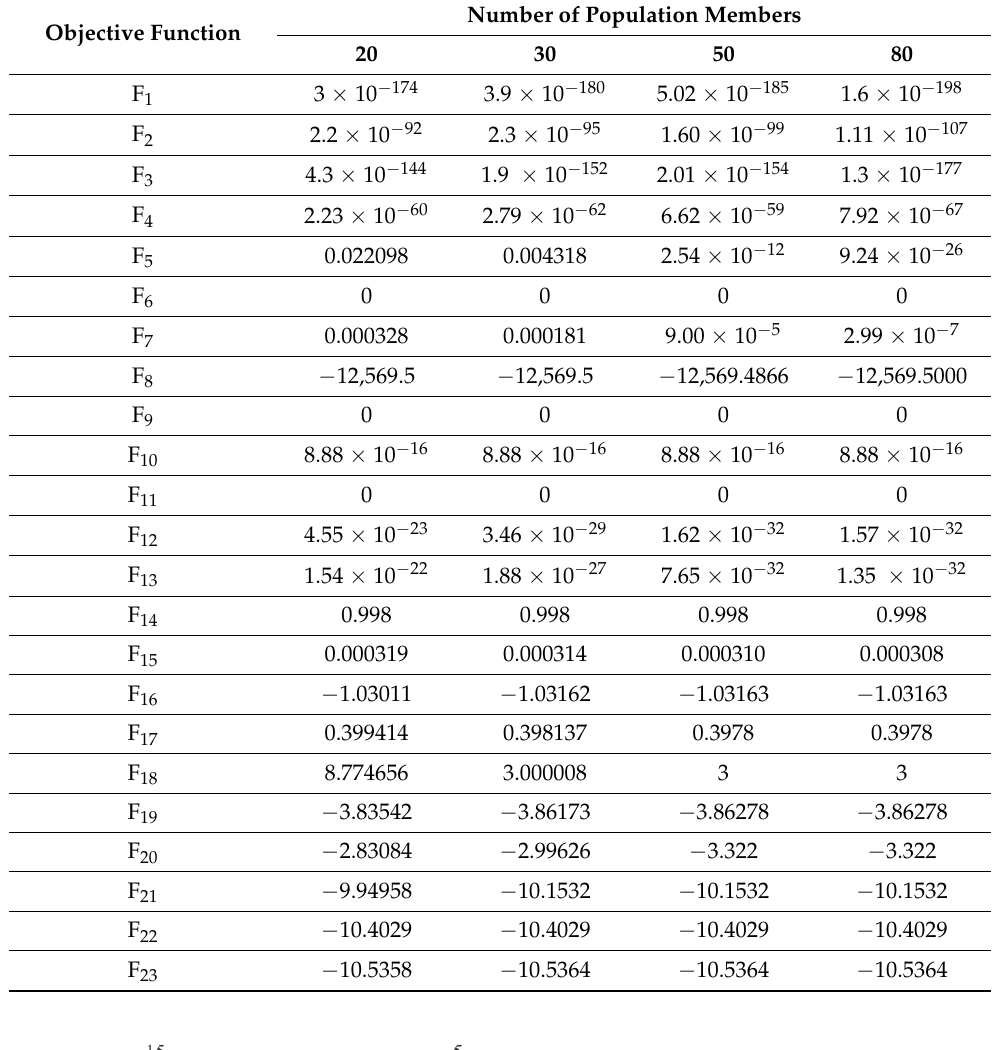
Table 6. Results of sensitivity analysis of SSVUBA to N .